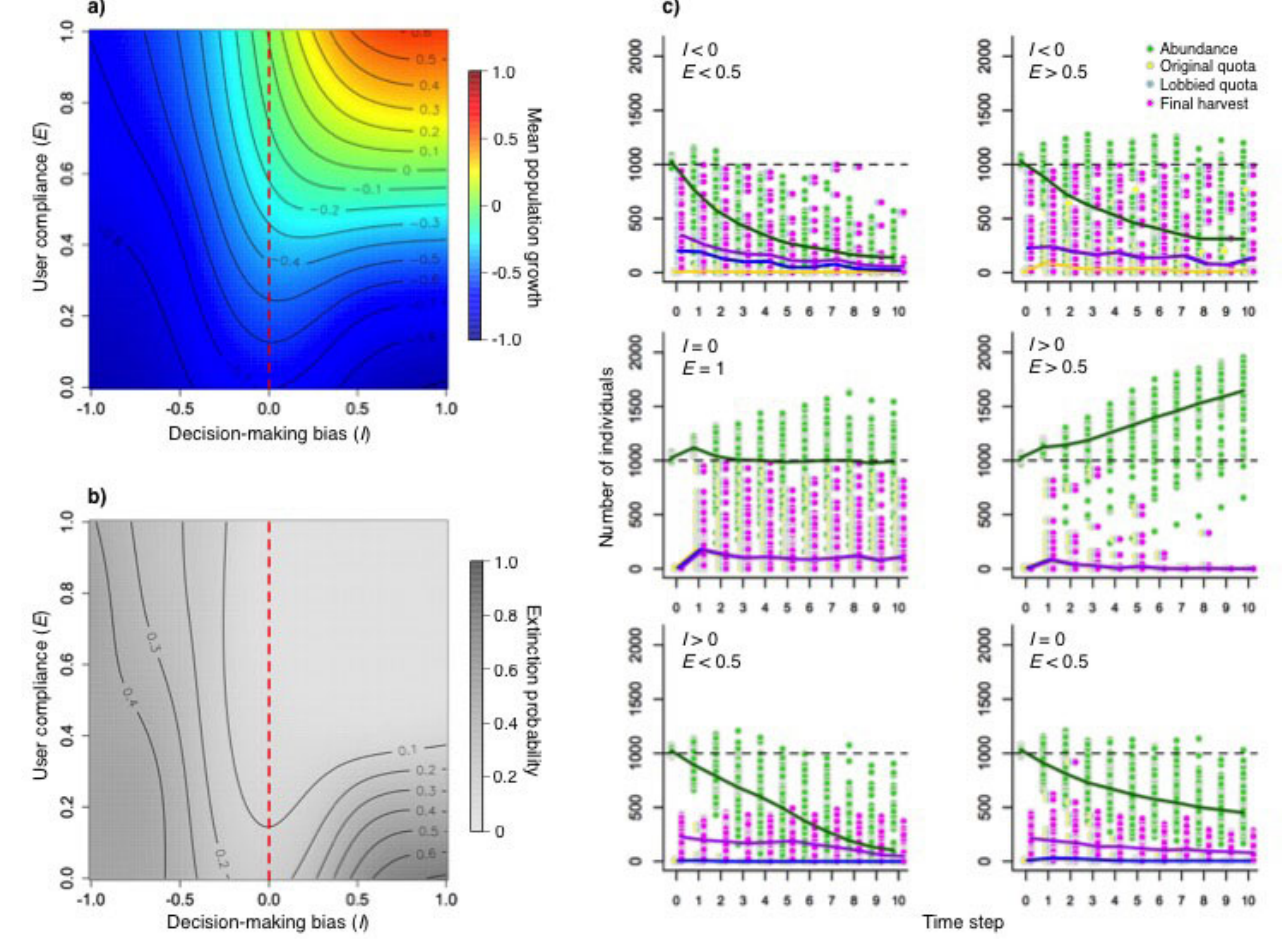
Fig. 3 . Mean population growth (a) and extinction probability (b) over a 10-year management period as a function of management decision-making bias and user compliance with harvesting rules. Panels in (c) relate to different areas of the model prediction surfaces, and illustrate time series of resource abundance, original quota put forward by the manager, modified quota as a result of lobbying, and final harvest including legal and illegal off takes for different combinations of decision-making bias and user compliance. Decision-making bias ranges from entirely pro-user (-1, harvest is always unregulated) to pro-conservation (+1, harvest is always banned), with 0 representing a scenario in which manager quota decisions cannot be lobbied (red dashed line). When user compliance is 0, users will always partake in illegal harvesting, while a value of 1 ensures users will fully comply with the quota put forward by the manager (postlobbying). The 2D contour surfaces were obtained from generalized additive models with decision- making bias and user compliance specified as tensor product smooths. Results are shown for a simulation in which the intrinsic growth rate of the harvested population was 0.2 and the carrying capacity was 2000